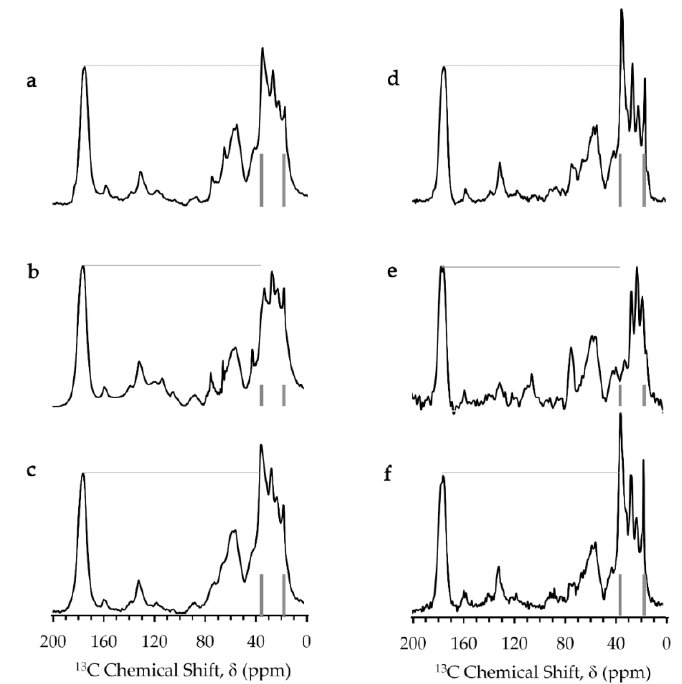
Figure 4. Solid-state 13 C-NMR spectra obtained by CPMAS (cross polarization magic-angle spinning, right column) and single 90 ◦ pulse (left column) experiments for E. coli samples containing ( a , d ) NaCl, ( b , e ) aqua Gd 3 + and ( c , f ) Gd-DOTA solutions. Carbonyl peak height and resonances for methyl carbon (16.8 ppm) and methylene carbon (35.5 ppm) of membrane lipids are marked by lines to guide the